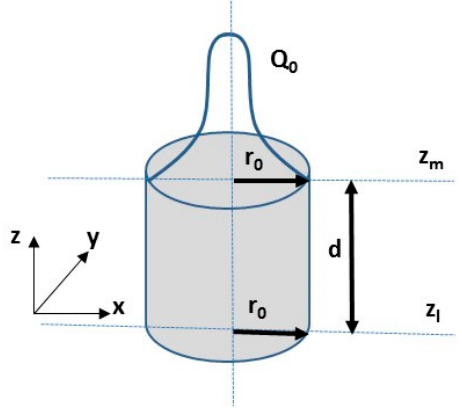
Figure 4. Cylindrical heat source model.